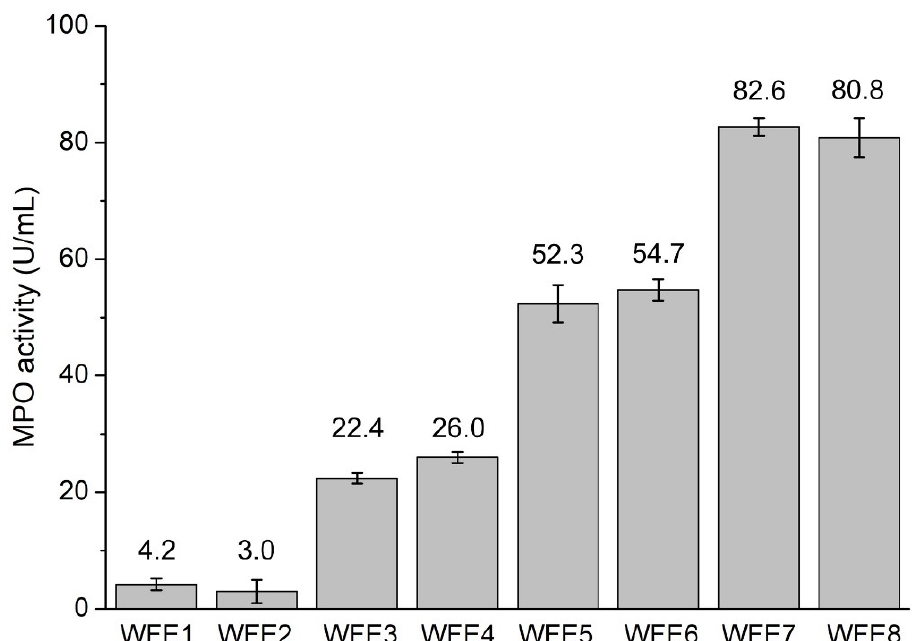
Figure 5. Ex vivo validation of the fluidic paper device with wound fluid extracts (WFE) at different infection levels that correlate with the MPO activity (N = 3). Each WFE was analyzed using the fluidic device (images) and spectrophotometrically (numerical values in U/mL of MPO in the WFE).